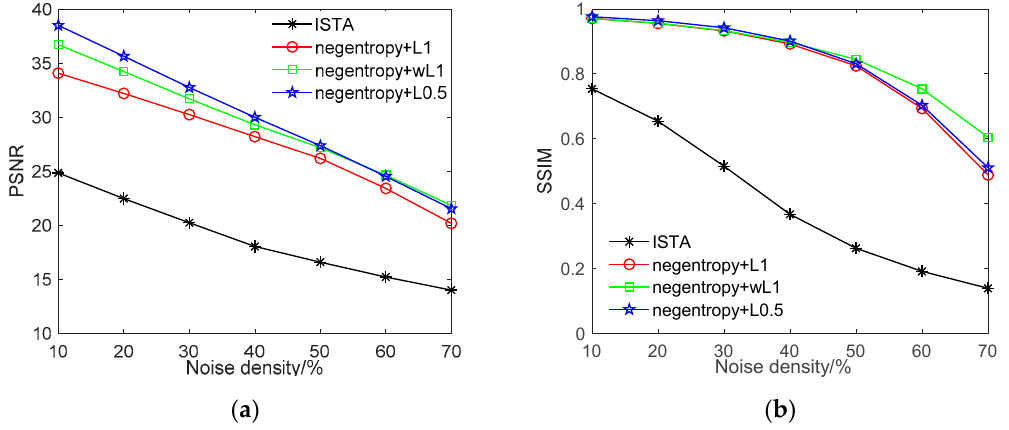
Figure 9. Comparison between ISTA and proposed algorithm for recovering image with salt and pepper noise with density from 10% to 70%. ( a ) PSNR value of recovered image versus noise density; ( b ) SSIM value between recovered images and original images versus noise density.